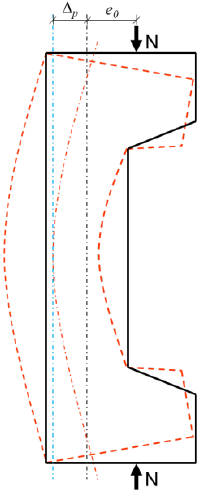
Figure 15. Schematic diagram of the second-order effect.